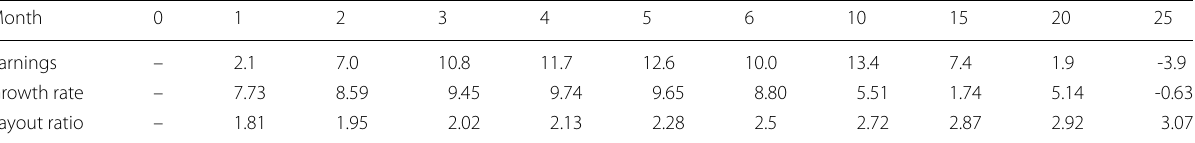
Table 5 Growth rate, % and dividend payout ratio based on the earnings